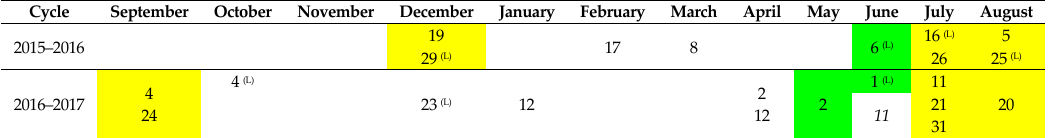
Table 1. Dates of S2 acquisition. (L) Denotes S2 images coinciding with Landsat images; green and yellow shading shows the presence of emergent vegetation covering marshland and rice-paddies, respectively.